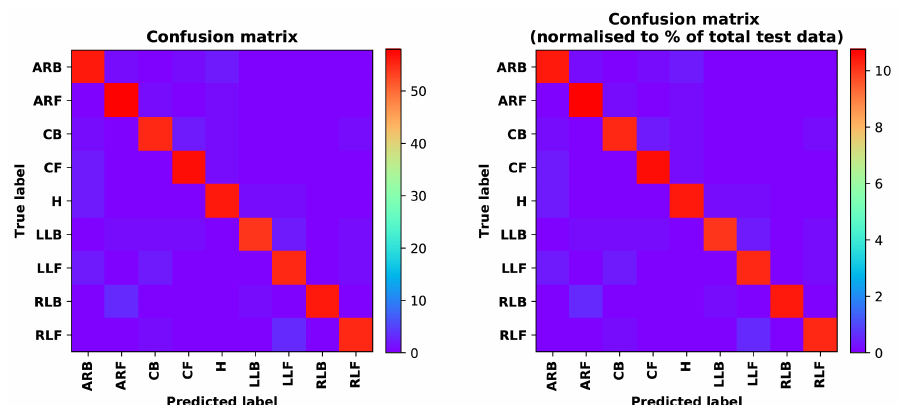
Figure 16. Left graph is the confusion matrix of classification test using the model trained by LSTM network with filtered measurements; right is the normalised confusion